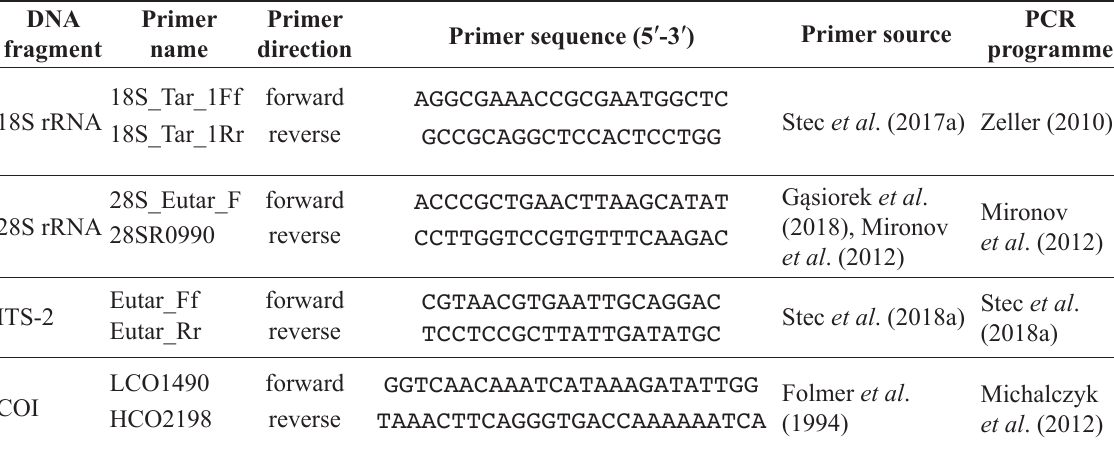
Table 1. Primers and references for PCR protocols for amplification of the four DNA fragments sequenced in this